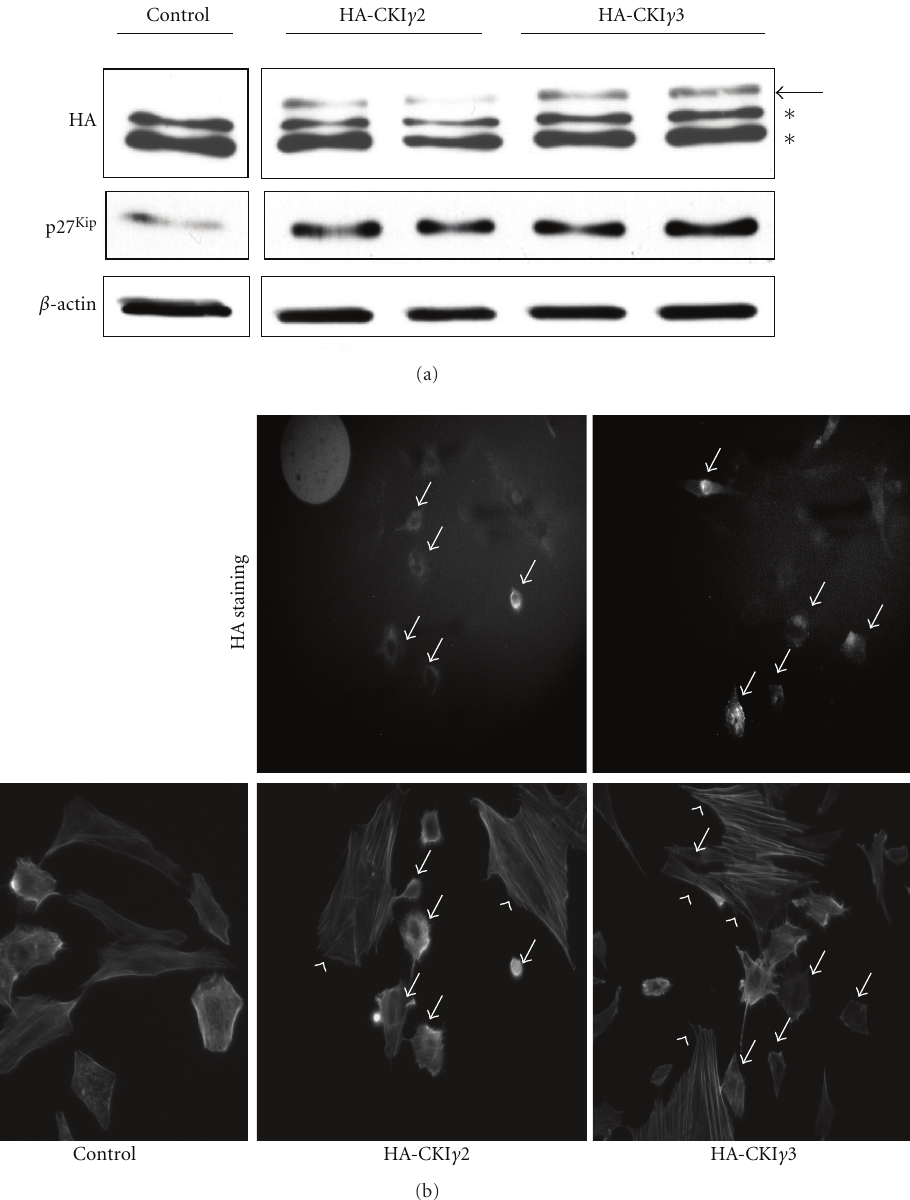
Figure 11: Overexpression of either CKI γ 2 or CKI γ 3 in fibroblasts increases expression of p27 Kip1 and inhibits formation of actin stress fibers. (a) Fibroblasts transiently transfected with plasmids encoding either HA-CKI γ 2 or HA-CKI γ 3 were analyzed for HA-tagged proteins and p27 Kip1 protein expression levels by Western Blot. The arrow represents HA-CKI γ 2 or HA-CKI γ 3, while nonspecific bands are indicated by asterisks. Actin was used as loading control. (b) Similar fibroblasts were stained for HA or actin organization using phalloidin coupled to AlexaFluor 488. Arrows indicate HA-positive cells, while arrow heads point nontransfected cells. Pictures were taken at